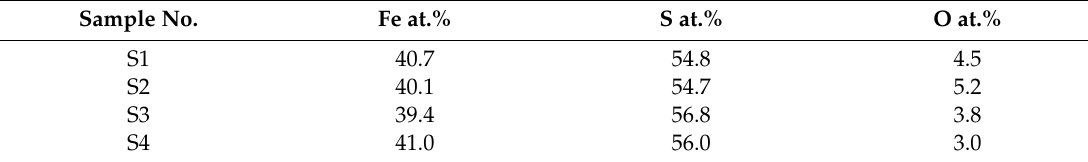
Table 2. Chemical composition measured by electron